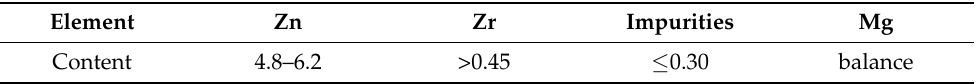
Table 1. Compositions of the wrought ZK60 magnesium alloy (wt.%).